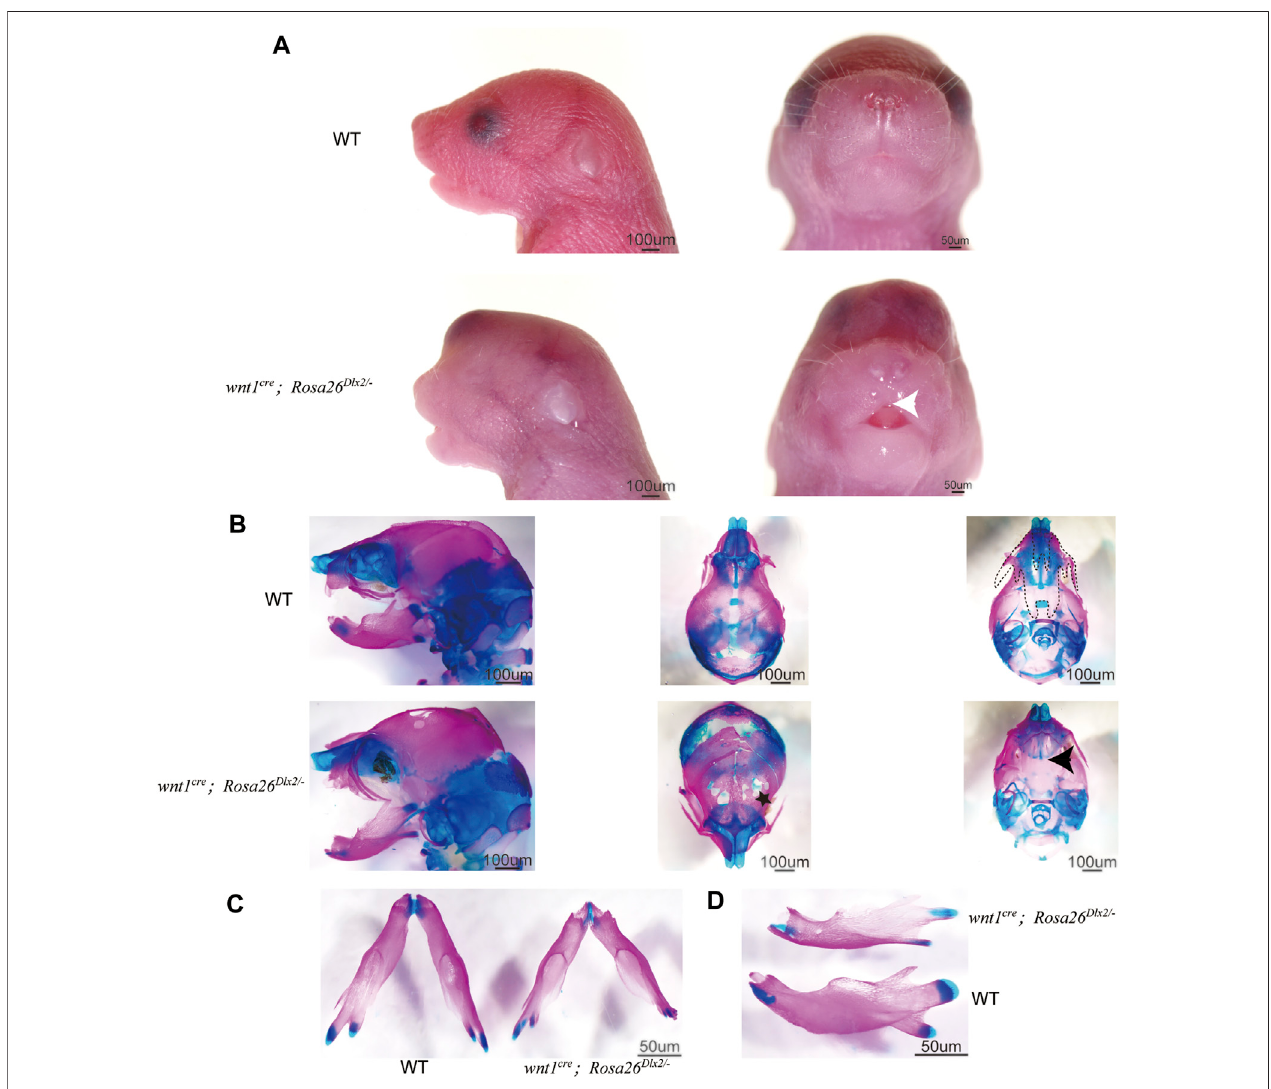
FIGURE 3 | Phenotype of wnt1 cre ; Rosa26 Dlx2/- mice at P0 (A) Stereo microscope images of P0 WT and wnt1 cre ; Rosa26 Dlx2/- mice. Wnt1 cre ; Rosa26 Dlx2/- mice exhibitamarkedlyshortermaxilla,atinycleftintheupperlip,abnormaleyedevelopment,andsofttissuebulgesonthehead (B-D) SkeletalstainingofP0WTand wnt1 cre ; Rosa26 Dlx2/- miceshowsarangeofevidentcraniofacialabnormalityin wnt1 cre ;Rosa26 Dlx2/- mice (B) Wnt1 cre ;Rosa26 Dlx2/- miceexhibitedapartialdefectoftheskulland parietal bones in addition to the short maxilla and cleft palate (C) Wnt1 cre ; Rosa26 Dlx2/- mice exhibit a shortened mandible (D) The temporomandibular joints of the wnt1 cre ; Rosa26 Dlx2/- mice are abnormally developed. The joint heads are smaller and the articular cartilage is insuf fi cient. The dotted line shows the range ofmaxilla and palatine,excludingthepremaxilla.Blackarrowsindicatecleftpalate,thewhitearrowpointstothetinycleftintheupperlip,andtheblackstarindicatesthepartialdefectof the frontal bones.